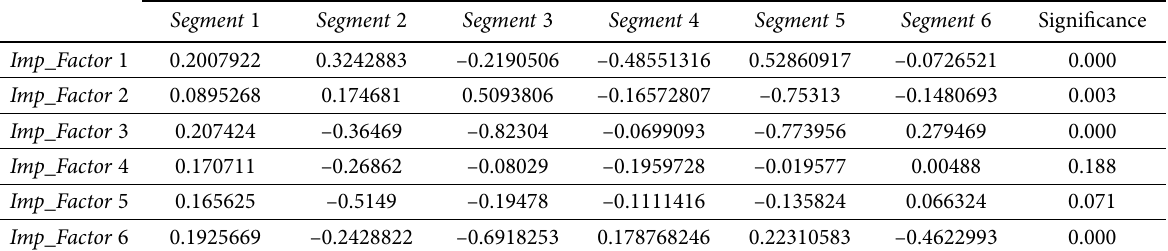
Table 17. ANOVA results for segments and importance factors (average factor loadings)